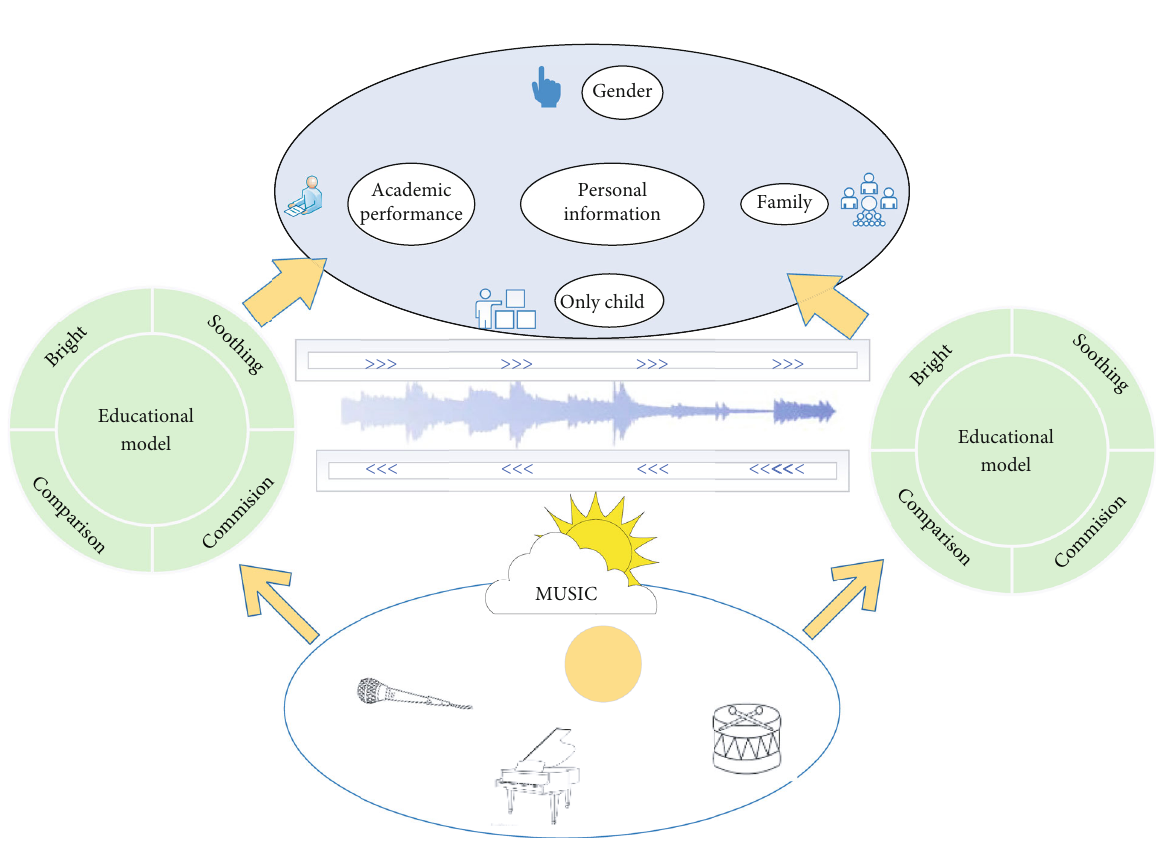
Figure 2: Research model of the e ff ect of di ff erent styles of music on stress relief for elementary school